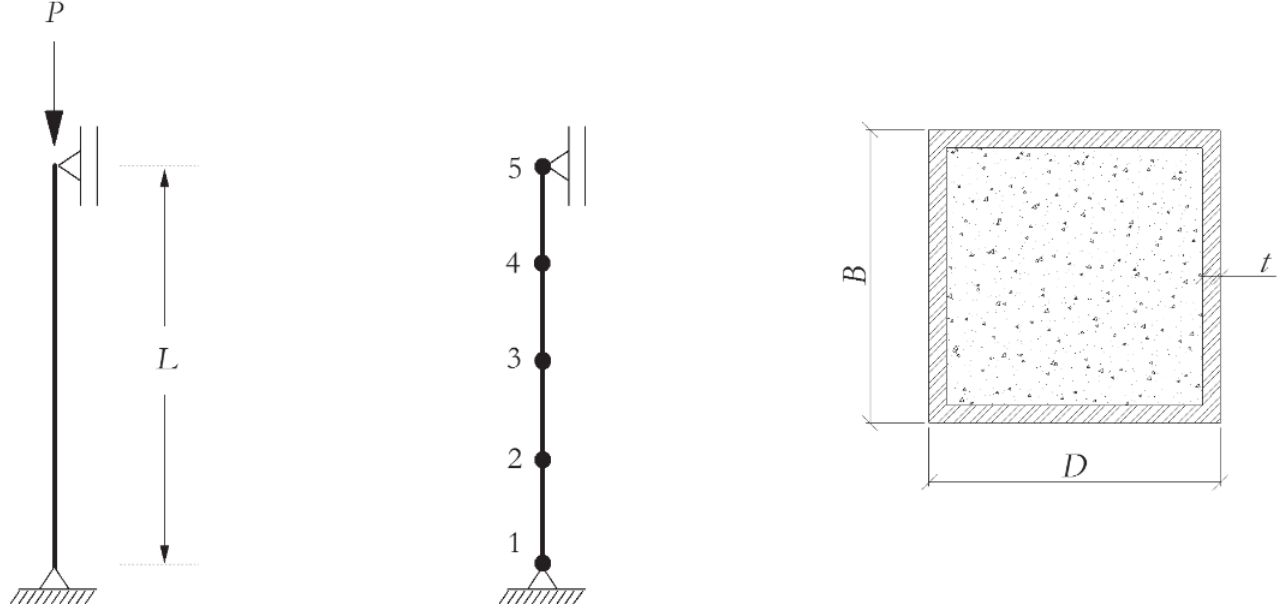
Idealized model for tubular rectangular composite column